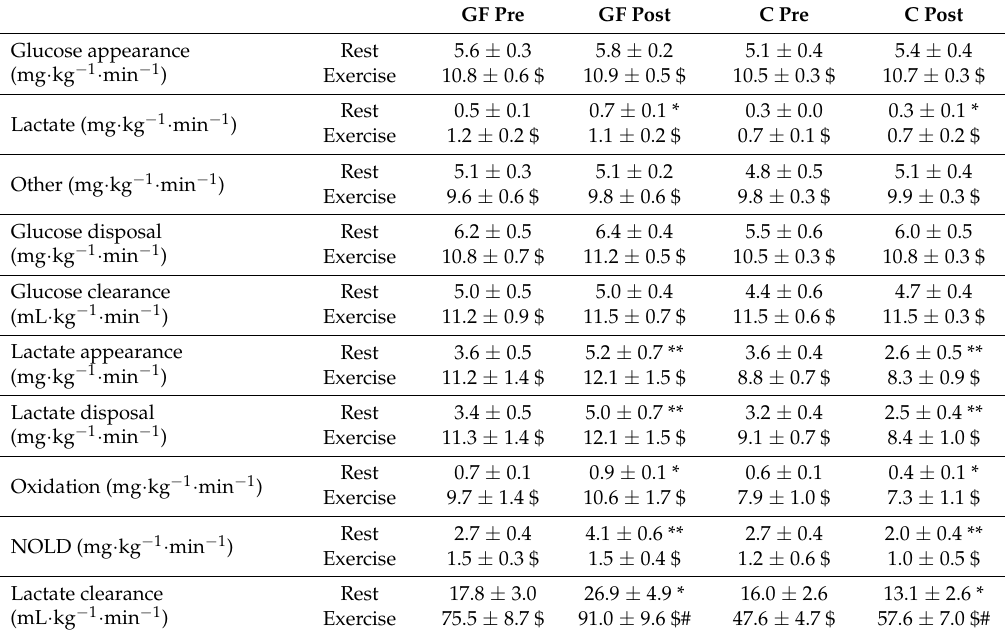
Table 2. Glucose and lactate fluxes in the resting and exercise periods GF Pre GF Post C